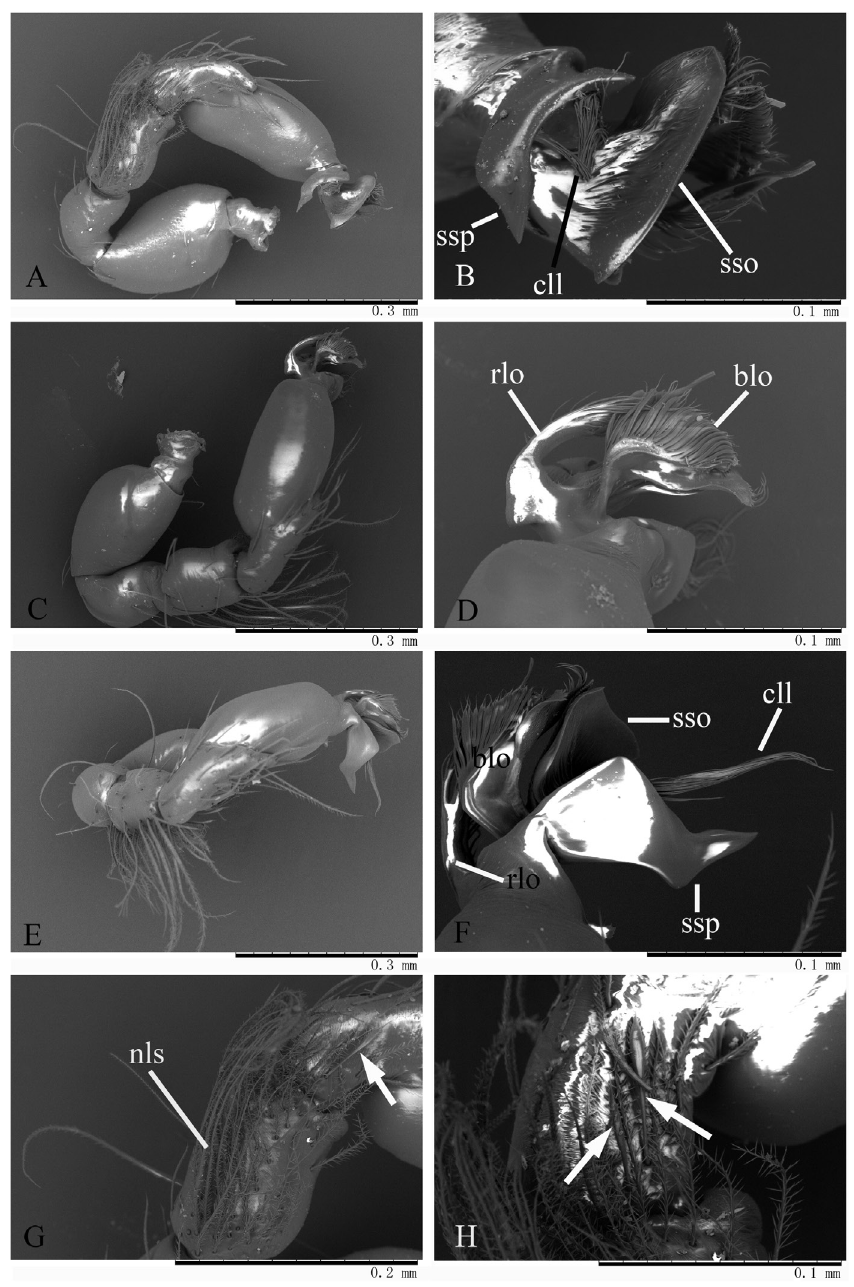
Figure 8. Trilacuna songyuae sp. n., male, SEM. A left palp, prolateral view B embolus system, prolateral view C left palp, retrolateral view D embolus system, retrolateral view E left palp, dorsal view F embolus system, dorsal view G tibia and cymbium, prolateral view H same, details, white arrow shows the spear-like setae. Abbreviations: blo = broom-like outgrowth; cll = cluster of long line-like structure; nls = numerous, long setae; rlo = ribbon-like outgrowth; sso = sector-shaped outgrowth; ssp = sickle-shaped